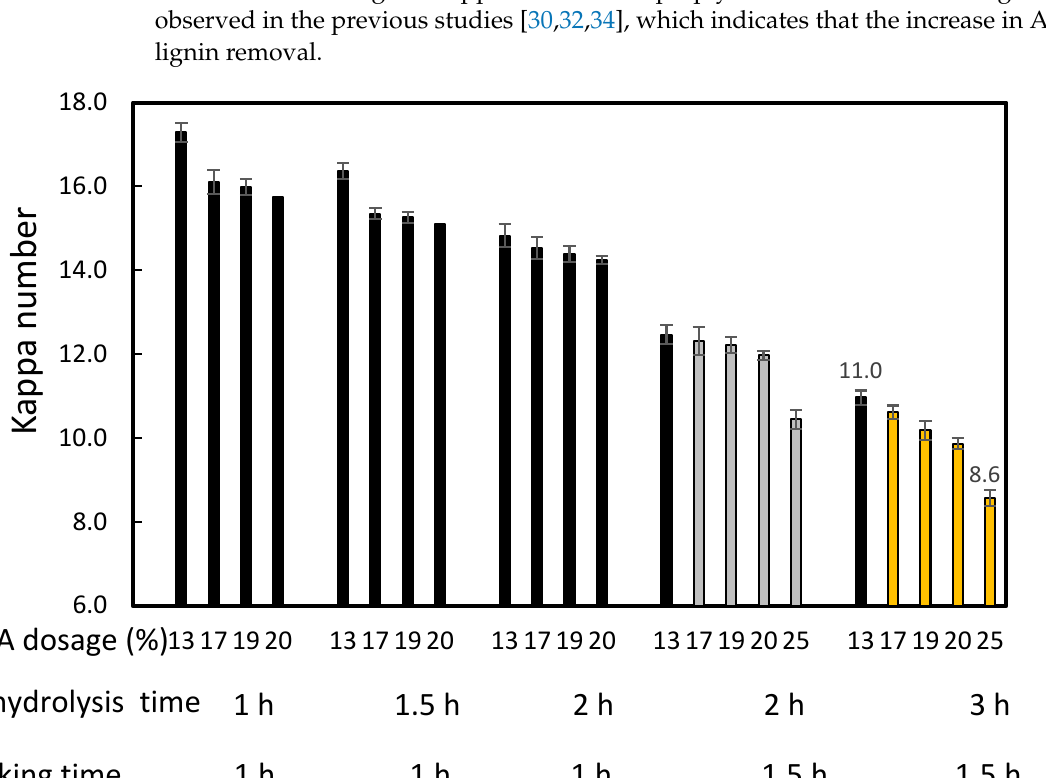
Figure 3. Effect of prehydrolysis time on the pulp yield of Nypa fruticans frond soda-SAQ pulp. The values presented are averages ± standard deviations.